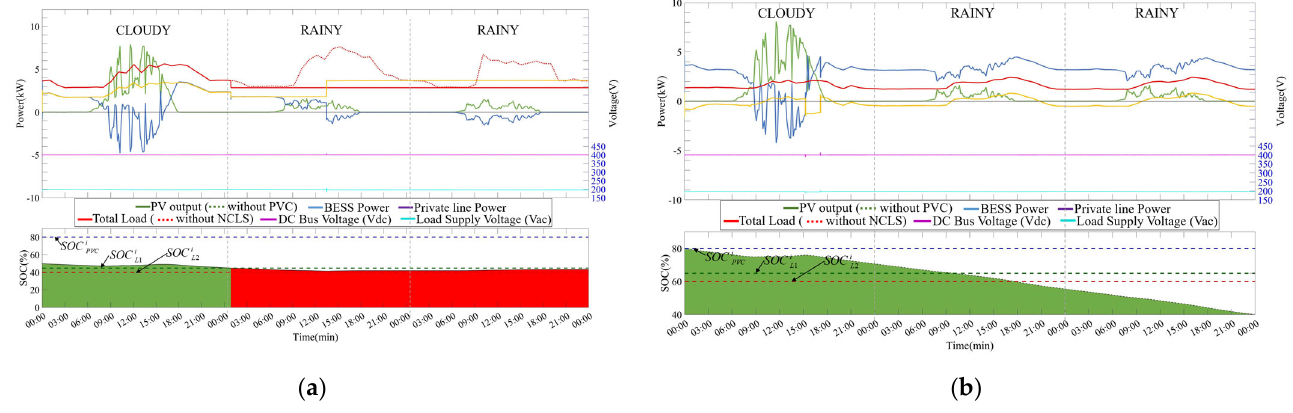
Figure 14. Test case 5 (Connected). ( a ) Performance of prosumer X. ( b ) Performance of prosumer Y.